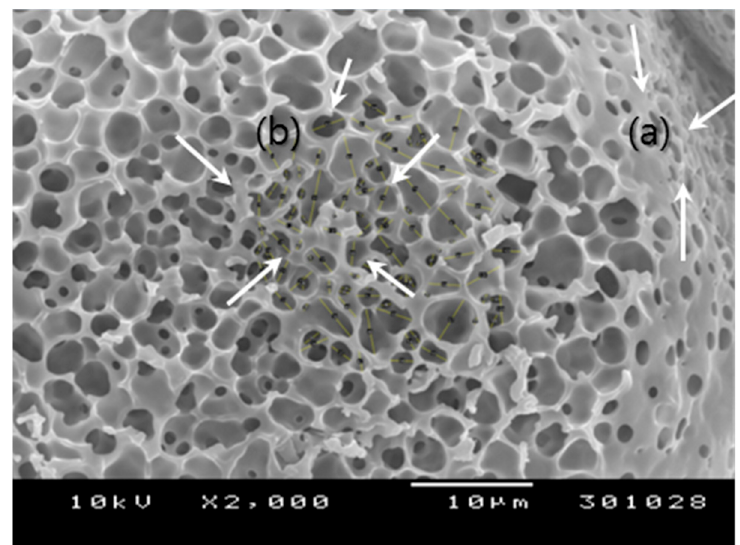
Figure 2. A SEM image showing ( a ) the surface and ( b ) internal morphology of a typical sponge-like PLGA microsphere (bar size = 10 µm). As a part of the microsphere surface is peeled off, its inside is exposed without damaging its internal structure. The surface and inside of the microsphere have numerous pores that are inter-connected to have an open pore structure.